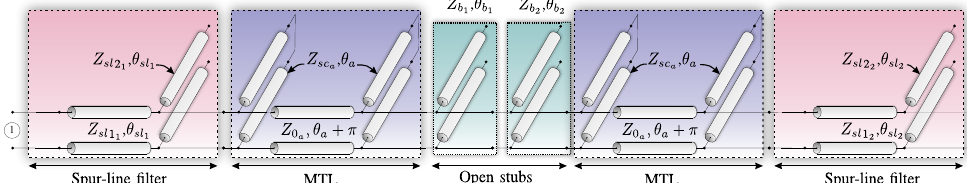
Figure 2. Equivalent circuit model for the proposed